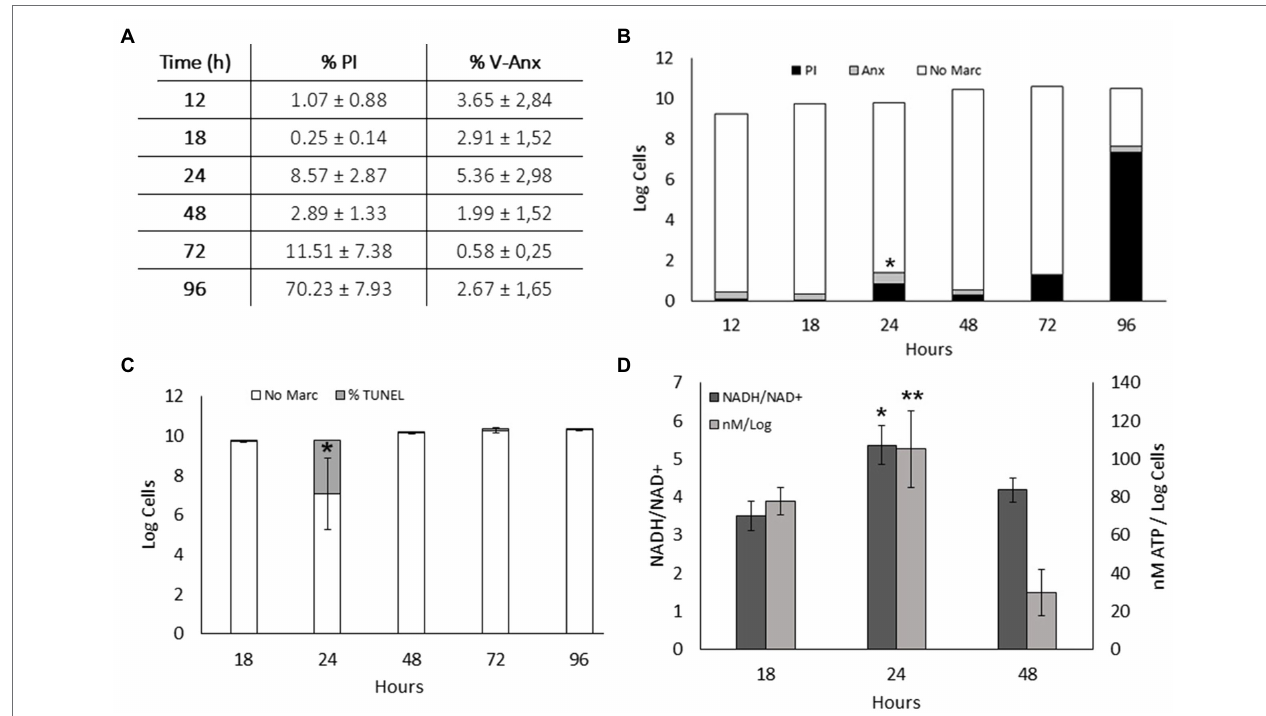
FIGURE 5 | Apoptosis-like death in S. vesiculosa M7 T cultures. (A) Exposure of phosphatidylserine in S. vesiculosa M7 T cells at different time points of the growth curve was analyzed by flow cytometry after PI and Annexin V-FITC staining. (B) Bars graph representing percentage of PI (black) and Annexin V-FITC (gray) stained cells and unstained cells (white) at different time points of growth. n = 3, ANOVA test, * p < 0.05 of Annexin V-FITC stained cells. (C) Bars graph representing the percentage of TUNEL (gray) stained and unstained cells (white) at different times of growth. n = 2, ANOVA test, * p < 0.05. (D) Metabolic markers, ATP and NADH, in S. vesiculosa M7 T cells at different times of growth. n = 3, ANOVA test, * and ** p <